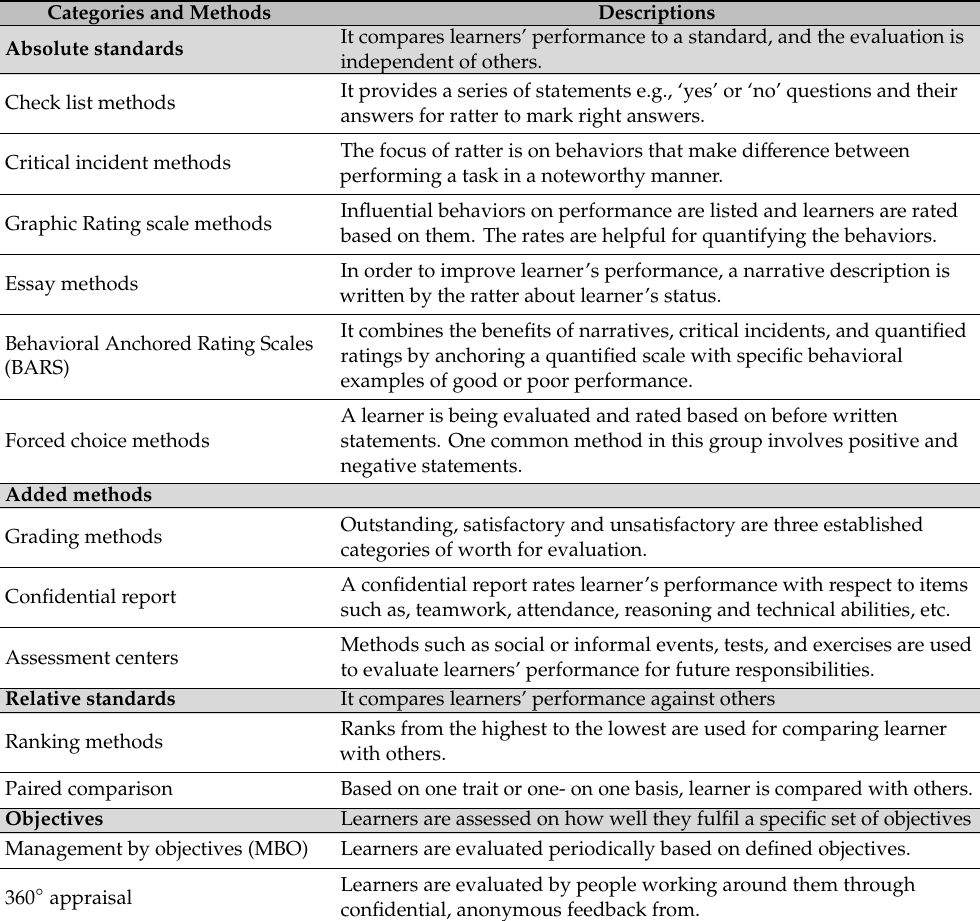
Figure 6. Methods for performance evaluation based on [105]. Table 11. Some partial descriptions of performance evaluation methods